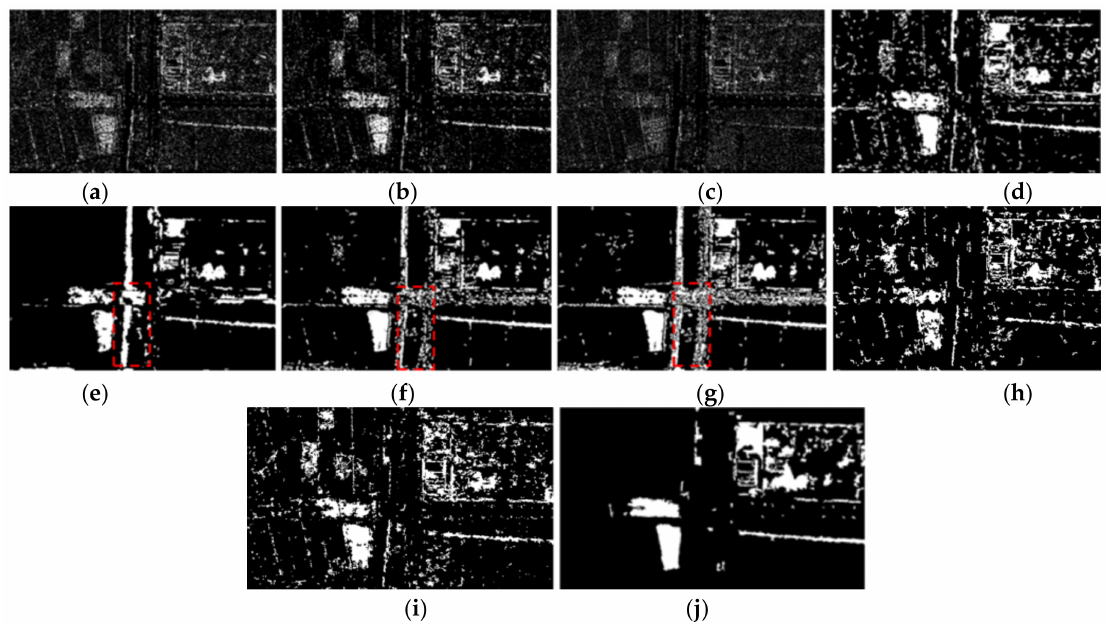
Figure 18. Binary change maps of Beijing SAR images generated by different methods: ( a ) LR;